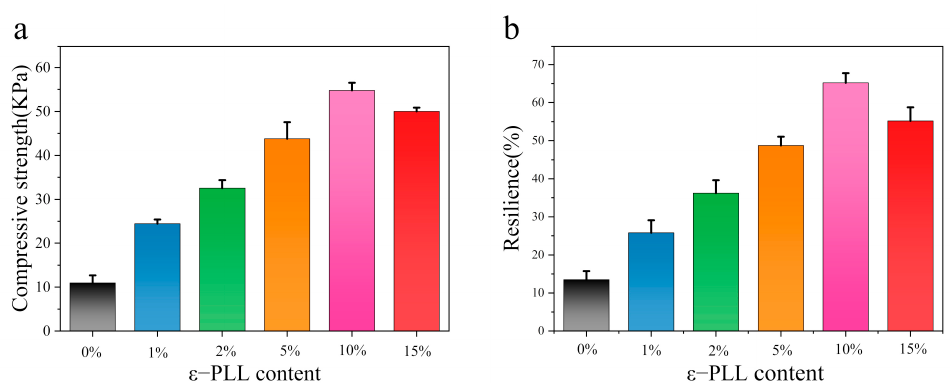
Figure 7. The mechanical properties of the hydrogel: ( a ) compressive strength; ( b ) compressive resilience. (The solid con- tent of SF and CSF solution is 3 wt.%, HRP concentration is 10 U/mL, H 2 O 2 concentration is 1 mM. n = 12 samples).